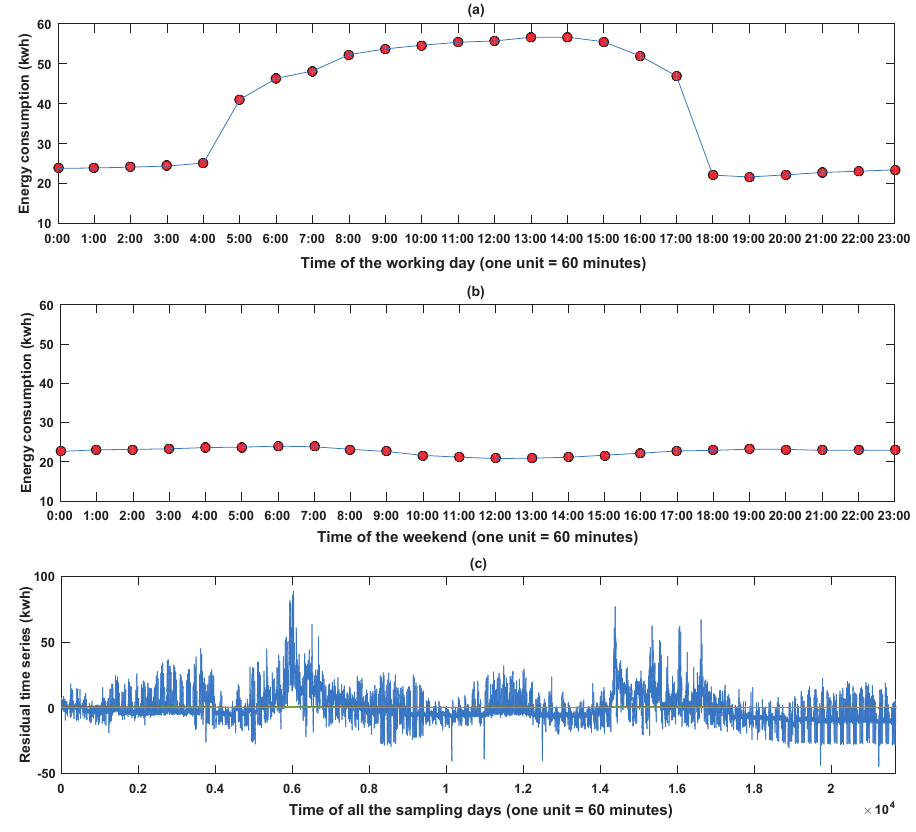
Figure 11. Periodicity knowledge and the residual time series of the office building data set: ( a ) the energy-consuming pattern of weekdays; ( b ) the energy-consuming pattern of weekends; ( c ) the residual time